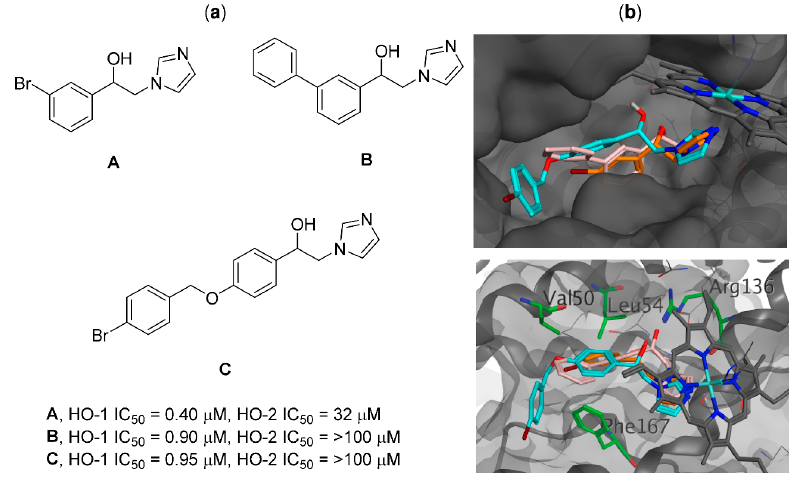
Figure 2. ( a ) Structures and HO IC 50 values of reference HO ‑ 1 inhibitors A – C and ( b ) their binding with the enzyme [31].